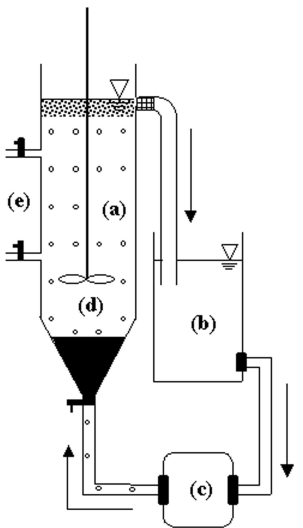
FIGURE 1. Set-up for the DAF treatment. (a) Sediment treatment tank, (b) circulation tank, (c) microbubble generator, (d) mixer equipment, (e) coagulation injection point. Arrows represent the direction of water